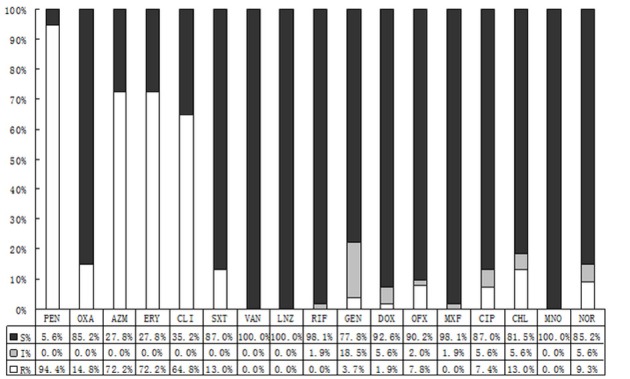
The antibiotic resistance patterns of Staphylococcus aureus (S. aureus) strains. S, Sensitive; I, Intermediate; R, Resistant; PEN, Penicillin; OXA, Oxacillin; AZM, Azithromycin; ERY, Erythromycin; CLI, Clindamycin; SXT, Trimethoprim-Sulfamethoxazole; VAN, Vancomycin; LNZ, Linezolide; RIF, Rifampicin; GEN, Gentamycin; DOX, Doxycycline; OFX, Ofloxacin; MXF, Moxifloxacin; CIP, Ciprofloxacin.